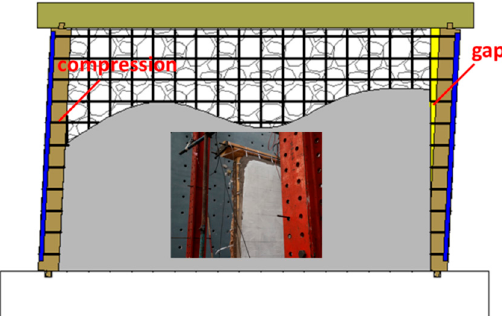
Figure 14. Deformation mechanism of the hybrid timber–stone wall strengthened by PP band mesh and cement mortar.